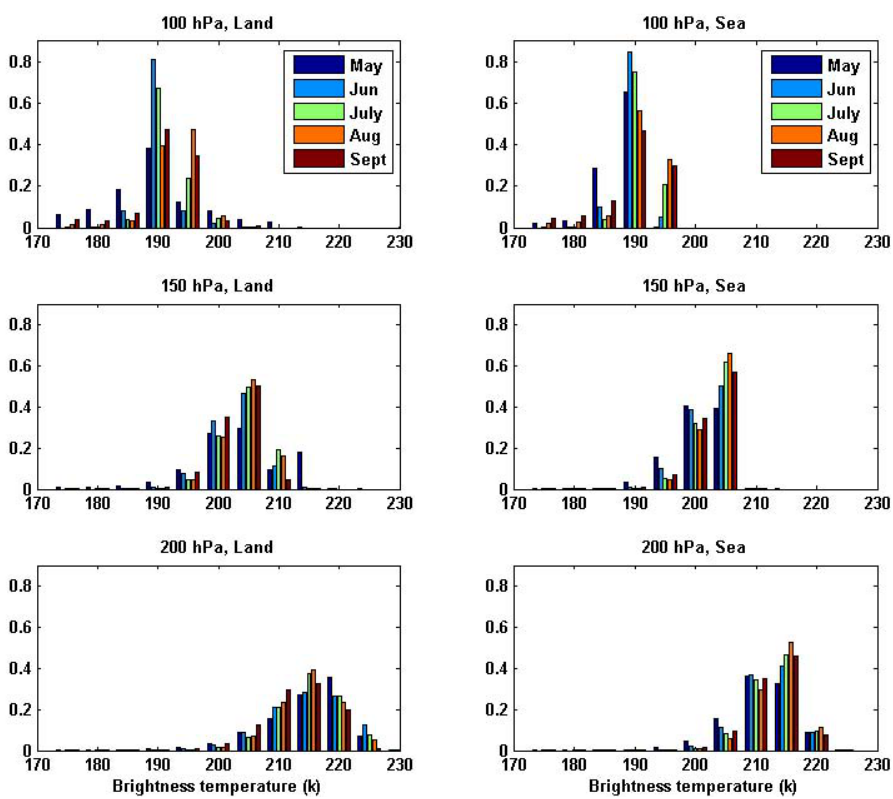
Fig. 4. Frequency distribution of the cloud top brightness temperatures from AVHRR binned into 5K intervals) with cloud tops higher than 200hPa (bottom row), 150hPa (middle row) and 100hPa (top row). The left column shows the frequency distribution for land areas only, while the right column shows for sea areas only. The entire study area shown in Fig. 1 is considered for the analysis. Note that the figures show the statistics of all brightness temperatures lower than the temperature of the corresponding pressure levels, and as such the statistics for, e.g. the 200hPa level includes those event that reach higher than 150hPa or even